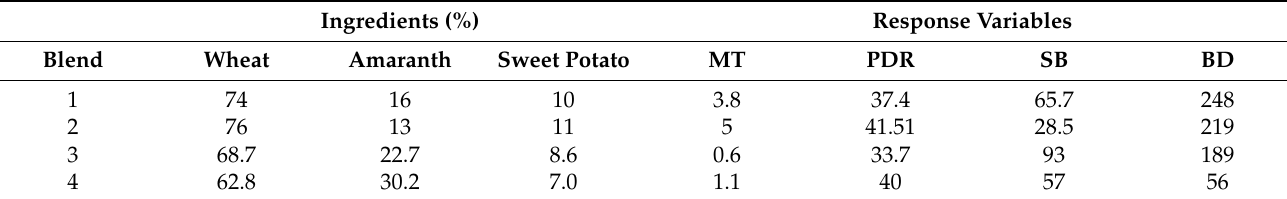
Table 4. Predicted optimized formulations of the blends.